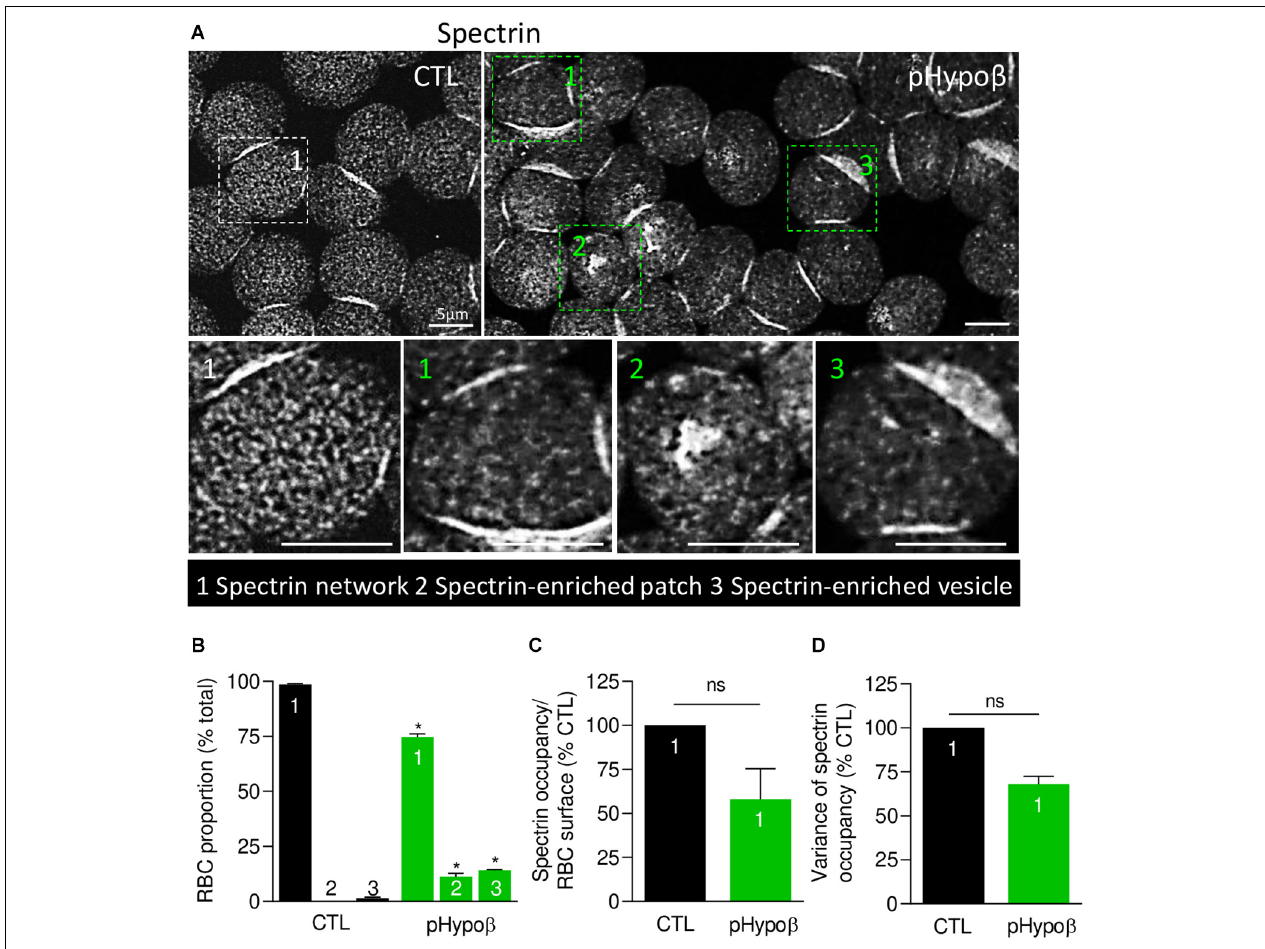
FIGURE 6 | The spectrin network is altered in pHypo β RBCs, showing either a lower density or a patchy or vesiculated pattern. RBCs from healthy donors (CTL, black) or pHypo β (green) were spread onto PLL-coated coverslips, fixed/permeabilized, immunolabelled for spectrin and visualized by confocal fluorescence microscopy using the same settings for sample illumination. (A) Representative general views and zooms of RBCs with homogenous spectrin network (1), spectrin-enriched patches (2) and spectrin-enriched vesicles (3). (B) Quantification of the relative proportion of RBCs with homogenous spectrin network (1), spectrin-enriched patches (2) or spectrin-enriched vesicles (3). Data are means ± SEM of 3–6 independent experiments. Mann–Whitney tests to compare each RBC population in healthy vs. pHypo β RBCs. * p < 0.05. (C,D) Quantification of spectrin occupancy normalized to the RBC surface (C) and variance of the spectrin labeling (D) in RBCs with homogenous spectrin network (population 1). Data are expressed as percentage of CTLs and are means ± SEM of 3 independent experiments. Mann–Whitney tests; ns, not